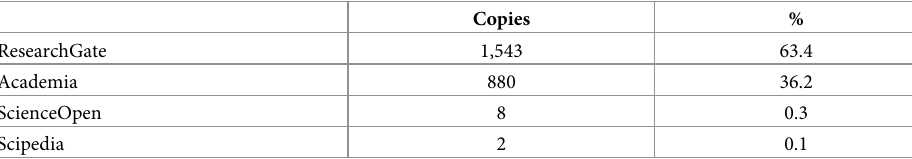
Table 12. Use of academic networks (based on copies found).